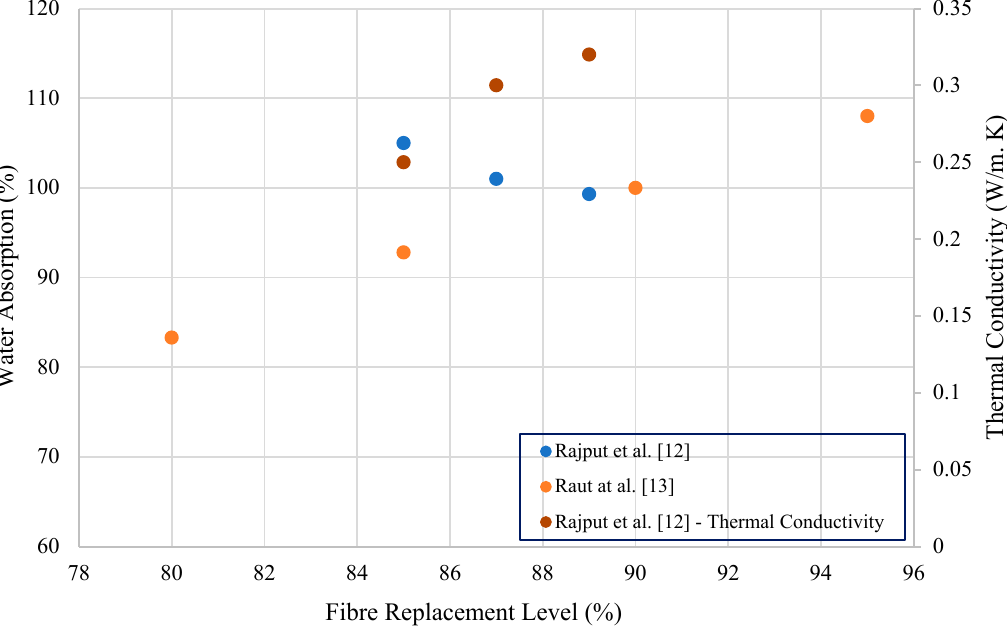
Figure 4. Water absorption and thermal conductivity variations of waste paper sludge cement composite binders.